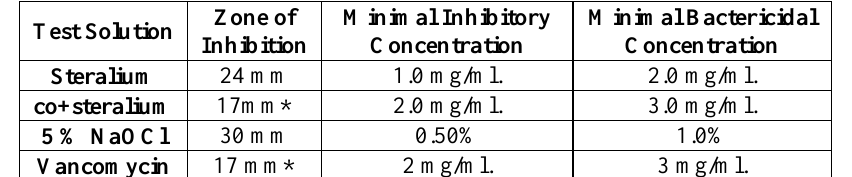
Table 1: Susceptibility of E. Faecalis ATCC 29212 against the Test Solutions